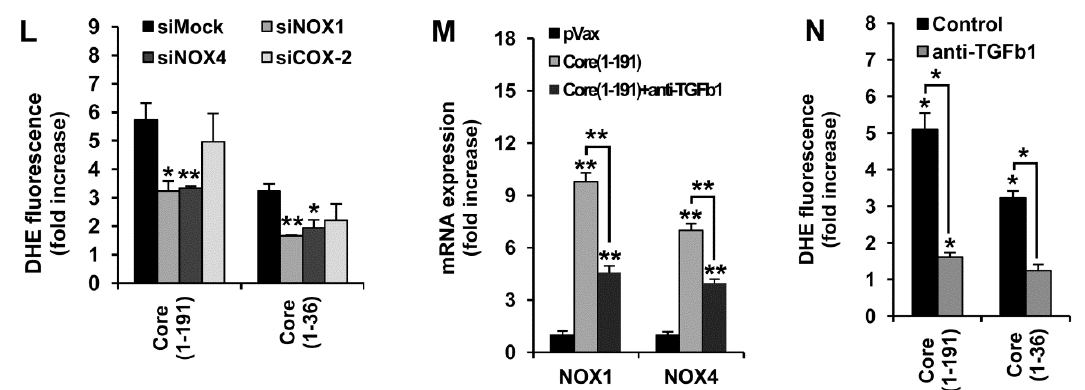
Figure 3. The N-terminus of HCV core protein triggers oxidative stress by independently inducing the expression of NOX1 and NOX4. ( A – E ) Quantification in Huh7 cells expressing the full length core(1–191) or truncated forms of HCV core protein core(1–36), core(37–191) or core(1–151) of the mRNA levels of NOX1 ( A ), NOX4 ( B ), TGF β 1 ( D ), and COX-2 ( E ); ( C , F ) Up-regulation of the translation of NOX1, NOX4 ( C ), and COX-2 ( F ) in Huh7 cells expressing the full length core(1–191) or truncated forms of HCV core protein core(1–36), core(37–191) or core(1–151) revealed by SDS-PAGE of the respective cell lysates with subsequent Western blotting using antibodies specific to NOX1, NOX4, or COX-2 (as depicted to the right); ( G ) Absence of co-regulation of expression of NOX1, NOX4, and COX-2 demonstrated by a selective inhibition of their expression in Huh7 cells expressing core(1–191) by the specific siRNA (given at the top); ( H – J ) siRNAs ensured an effective suppression of expression of the respective protein as revealed by Western blot analysis; ( K , L ) DCFH ( K ) and DHE ( L ) staining reveals a partial inhibition of ROS production induced by core(1–191) and core(1–36) in Huh7 cells after silencing of expression of NOX1, or NOX4, or COX-2 with specific siRNAs; ( M , N ) Suppression of the expression of NOX1 and NOX4 ( M ) and of superoxide anion production ( N ) in Huh7 cells expressing core(1–191) by antibodies specific to TGF β 1 (see Materials and Methods section for experimental details). Huh7 cells transfected with the empty pVax1 vector or pVax1 expressing NS5B served as negative controls. Levels of NOX1, NOX4, TGF β 1, or COX-2 mRNA were first expressed as relative to the content in the sample of mRNA of β -actin, and then normalized to the relative content of the respective mRNA in Huh7 cells transfected with the empty vector pVax1. Levels of superoxde anion were measured using DHE. All data represent the means ± S.D. from triplicate measurements done in three independent experiments. * p < 0.01; ** p < 0.001.